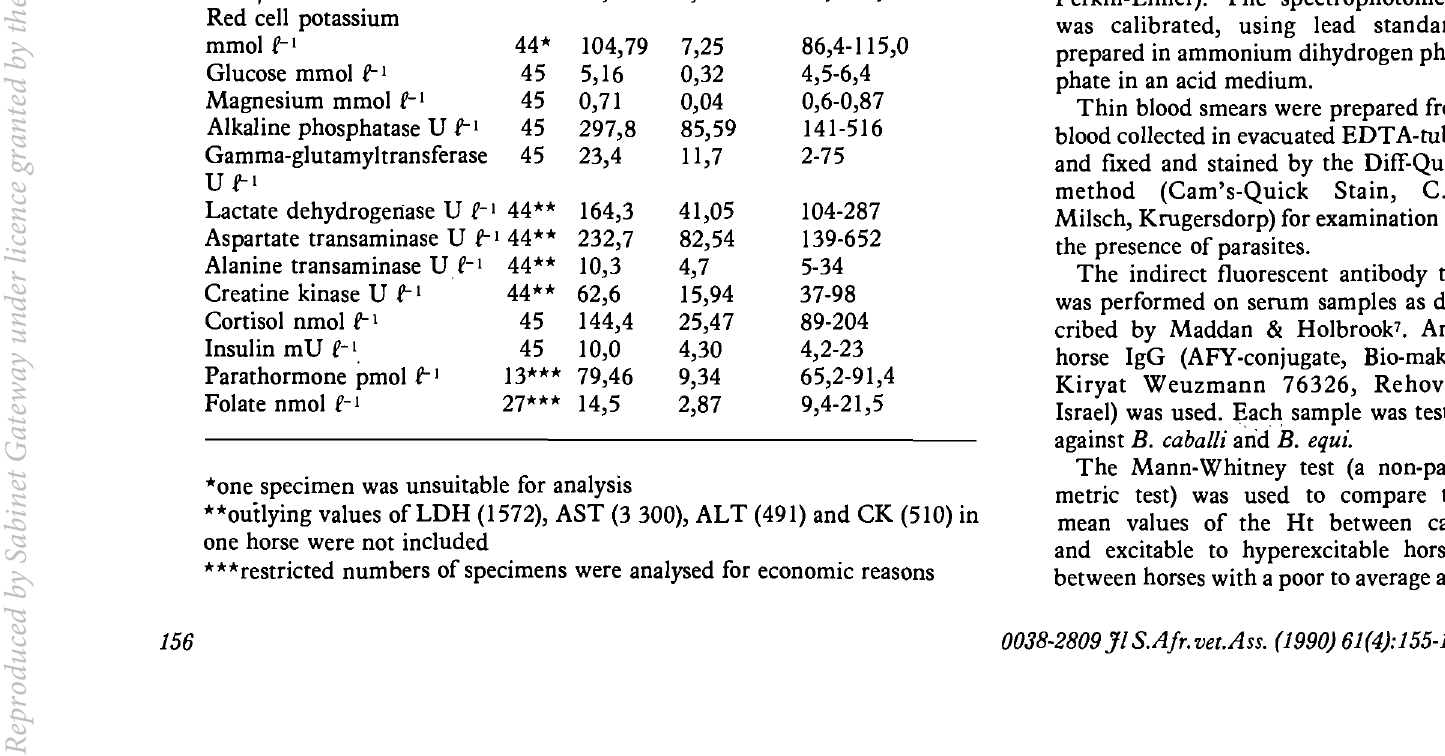
Table 2: Electrolyte, urea, creatinine, total protein, albumin, bilirubin, iron, glucose, enzyme, cortisol, insulin, parathormone and folate concentrations in Thoroughbreds n